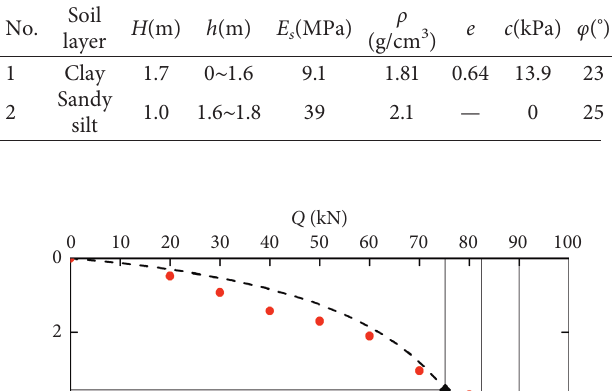
Table 4: Basic physical and mechanical parameters of the ground at the test site.